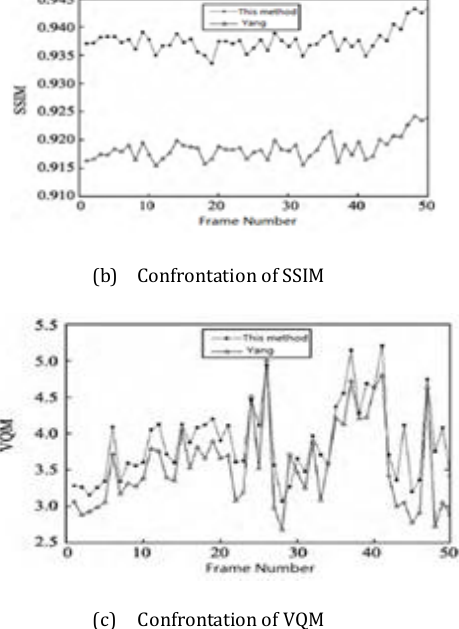
Figure 9: Qualitative comparison of the two algorithms